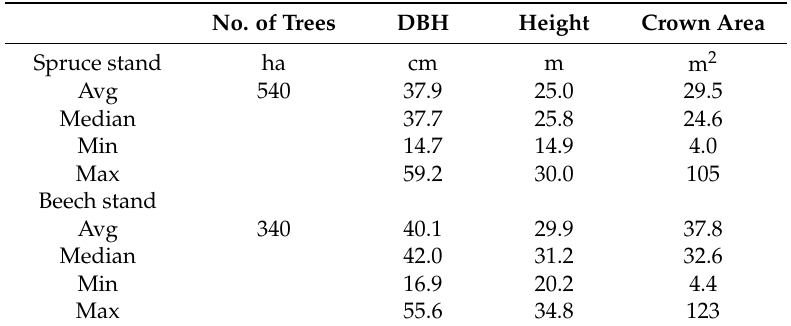
Table 1. Number of trees (trees · ha − 1 ) and their DBH (diameter at breast height), tree height and crown area (m 2 ) characteristics in both stands.